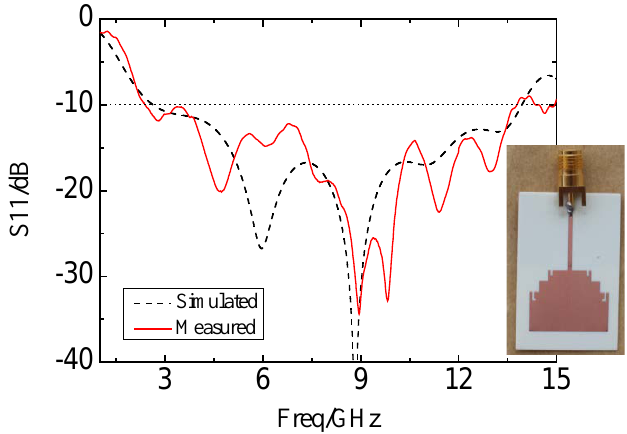
Micromachines 2020 , 11 , x FOR PEER REVIEW Figure 14.